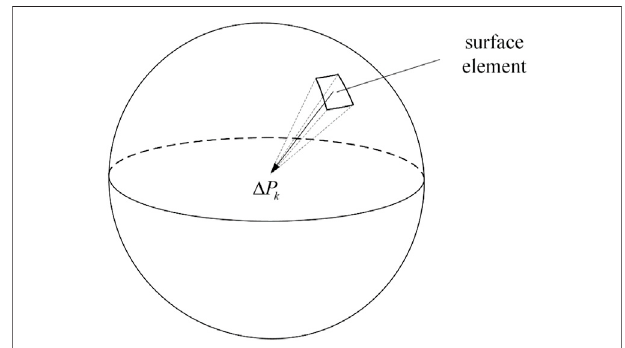
FIGURE 2 | Schematic of the electric fi eld force of liquid metal